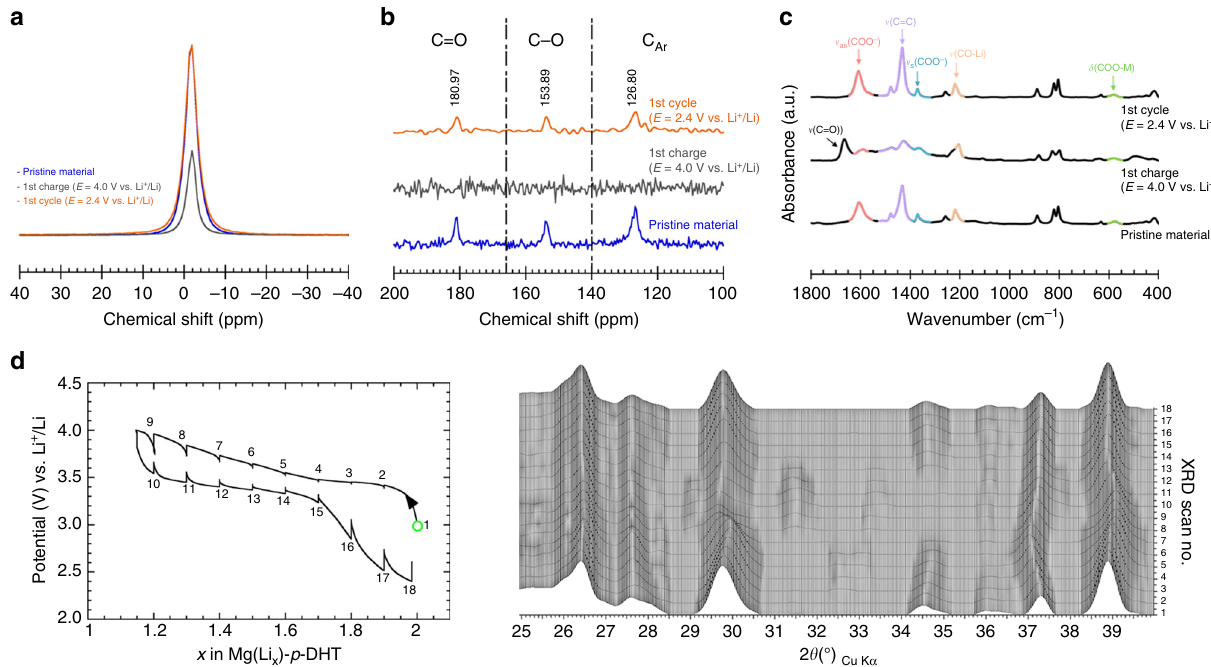
Fig. 6 Supporting data for one-electron limited electrode process. a Ex situ 7 Li MAS-NMR spectra. b Corresponding ex situ 13 C CP MAS-NMR spectra using micrometric-sized Pt particles in place of carbon black conducting additive. c FTIR data for Mg(Li 2 )- p -DHT-based electrodes containing 33 wt.% Ketjenblack EC-600JD before cycling (blue), after a fi rst charge up to 4 V vs. Li + /Li (gray) and one full cycle (orange), within the 2.4 – 4.0 V potential range (rate: 1 Li + /5 h). d Potential-composition pro fi le for a Mg(Li 2 )- p -DHT/Li in situ XRD electrochemical cell 63 together with the corresponding collected XRD patterns over the 10 – 40° 2 θ range. The cell was cycled in the 2.4 – 4.0 V potential range using an intermittent galvanostatic mode. More speci fi cally, a current of 11.2 mA per g of Mg(Li 2 )- p -DHT (rate: 1 Li + /10 h) was applied for a period of 2 h, separated by resting periods of 1 h during which the XRD patterns were collected (electrolyte: LiPF 6 1 M in